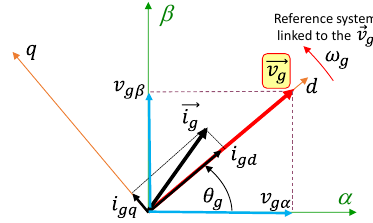
Figure 3. Grid voltage reference system.